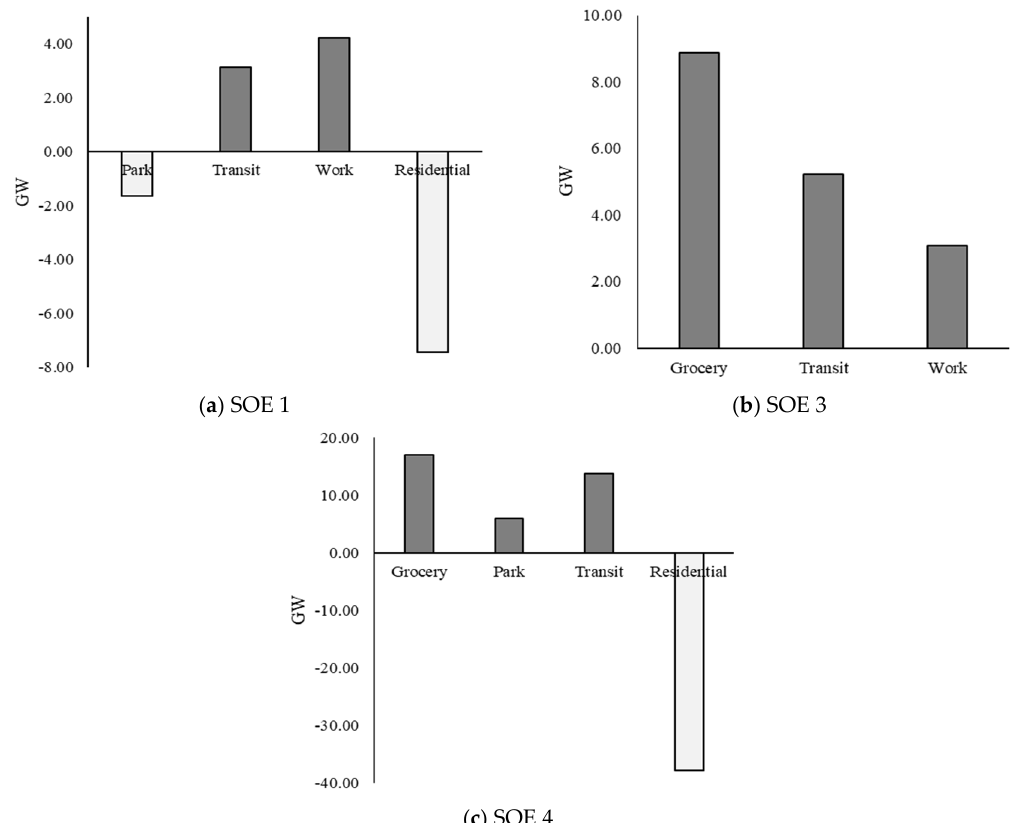
Figure 3. Long-term effects of human mobility change on electricity consumption. The figure presents those results that were significant at the 5% level in Table 7.